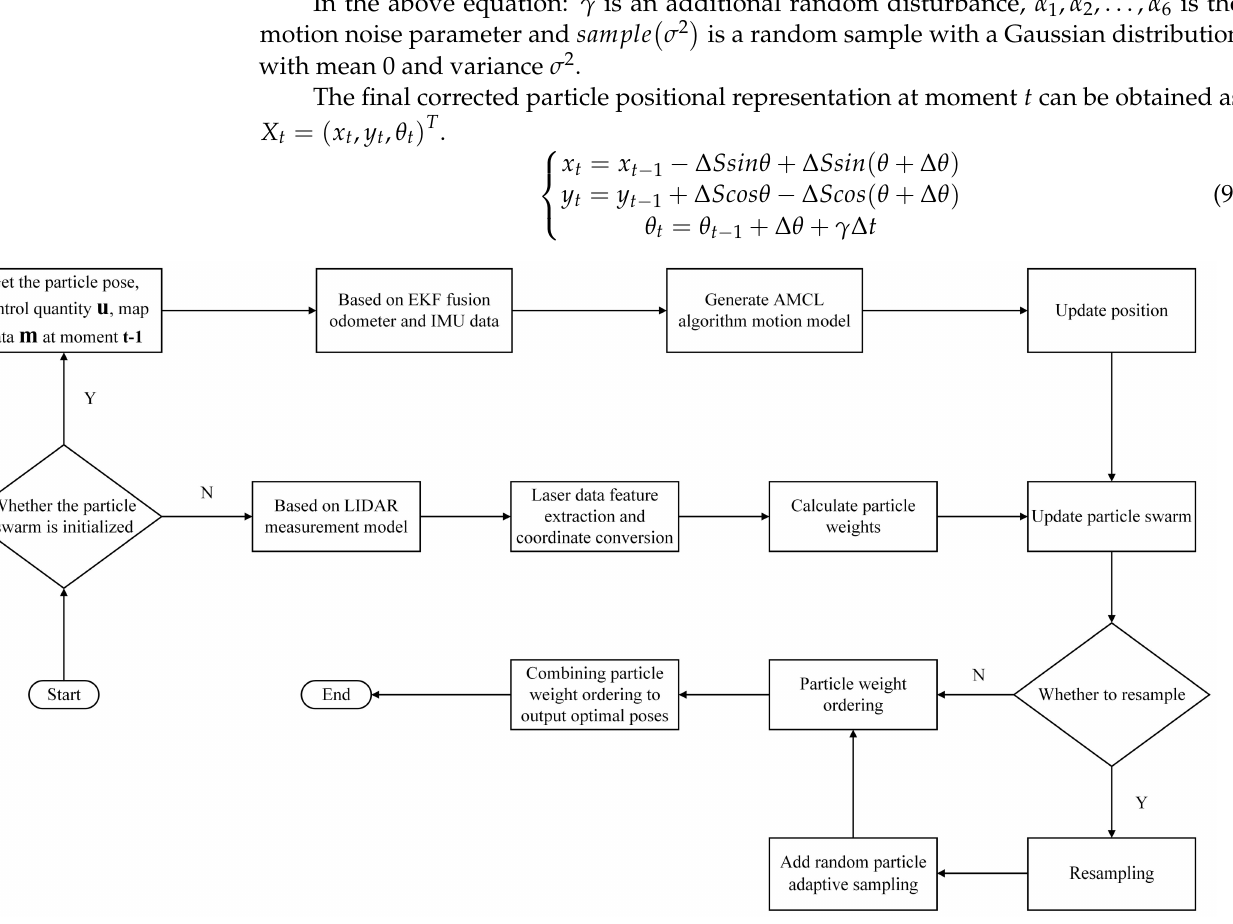
Figure 2. AMCL algorithm flow based on EKF fusion